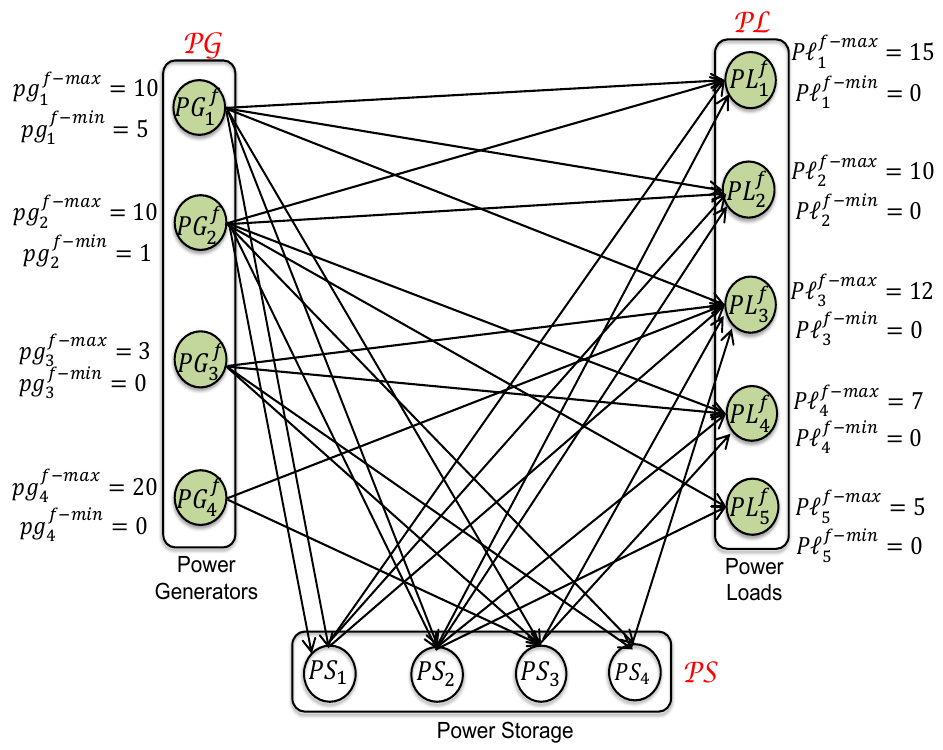
Figure 11. Simulation scenario consisting of power generators, power loads, power storage devices, and connections between them.